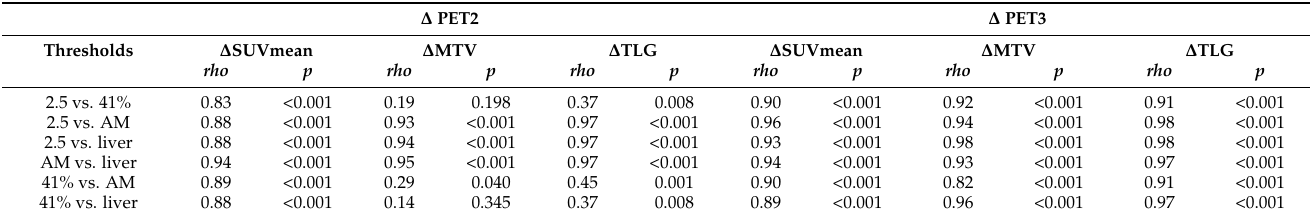
Table 3. Comparison of different delta threshold values by means of linear